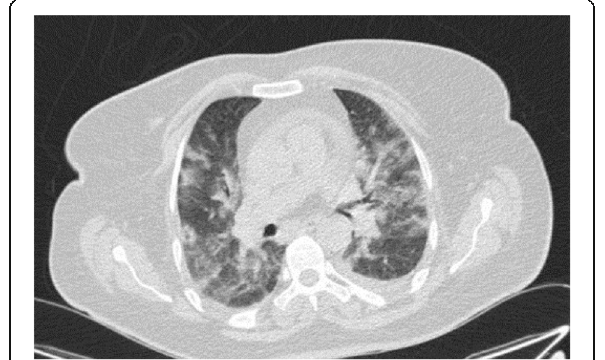
Fig. 12 COVID-19pneumonia: parahilar GGO without round configuration and bilateral pleural effusion, despite indeterminate findings for COVID-19 pneumonia, RT-PCR test was positive for COVID-19